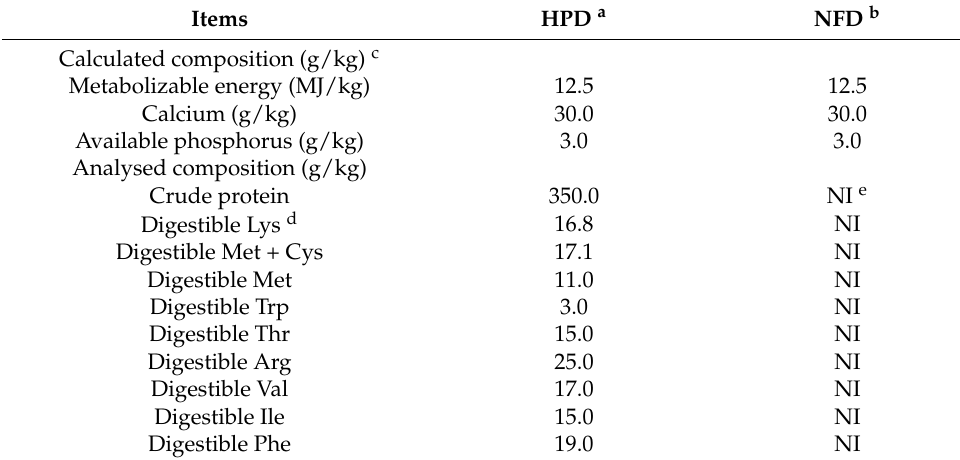
Table 2. Nutritional levels of experimental